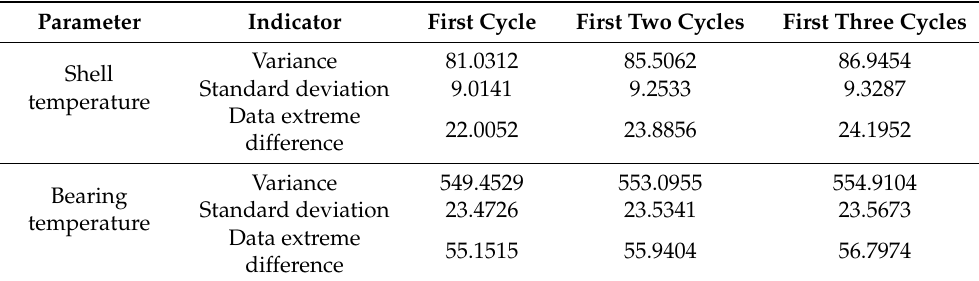
Figure 5. Ten years of operational data after preprocessing. The initial phase of the component run data is more stable. The benchmark is quantified by the variance, standard deviation, and data extreme difference for different cycle quantities of data. The indicators are calculated as shown in Table 1. Table 1. Calculation of health benchmark indicators.